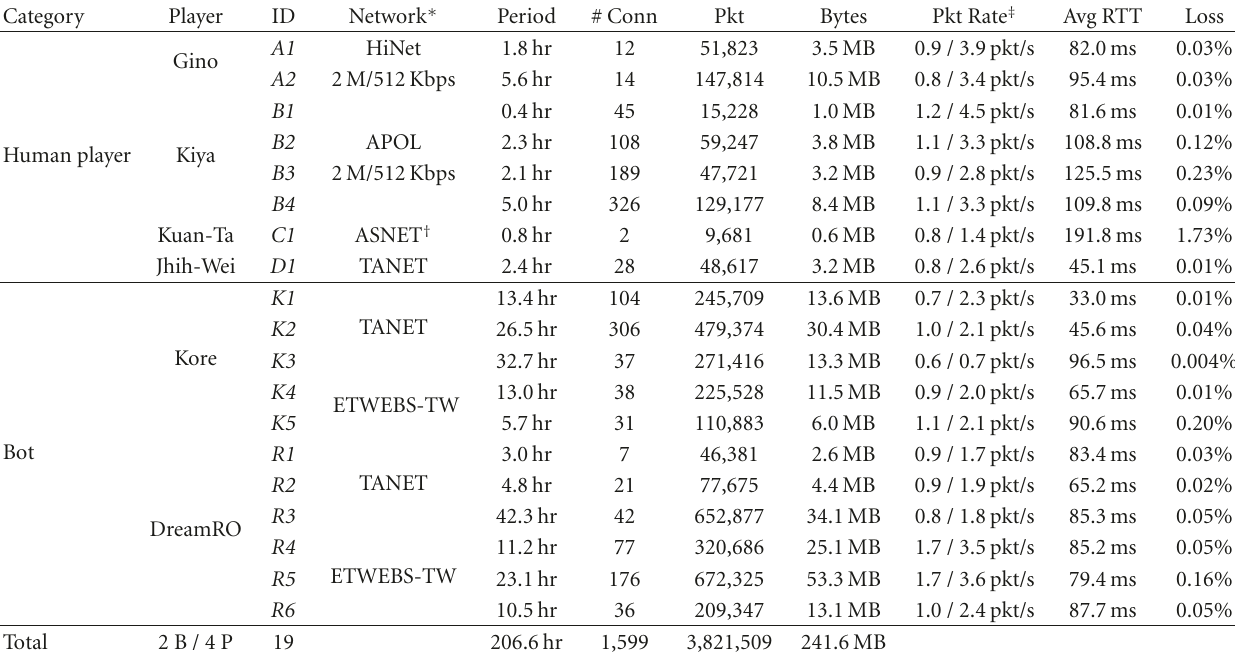
Table 1: Game tra ffi c traces (206 hours and 3 million packets in